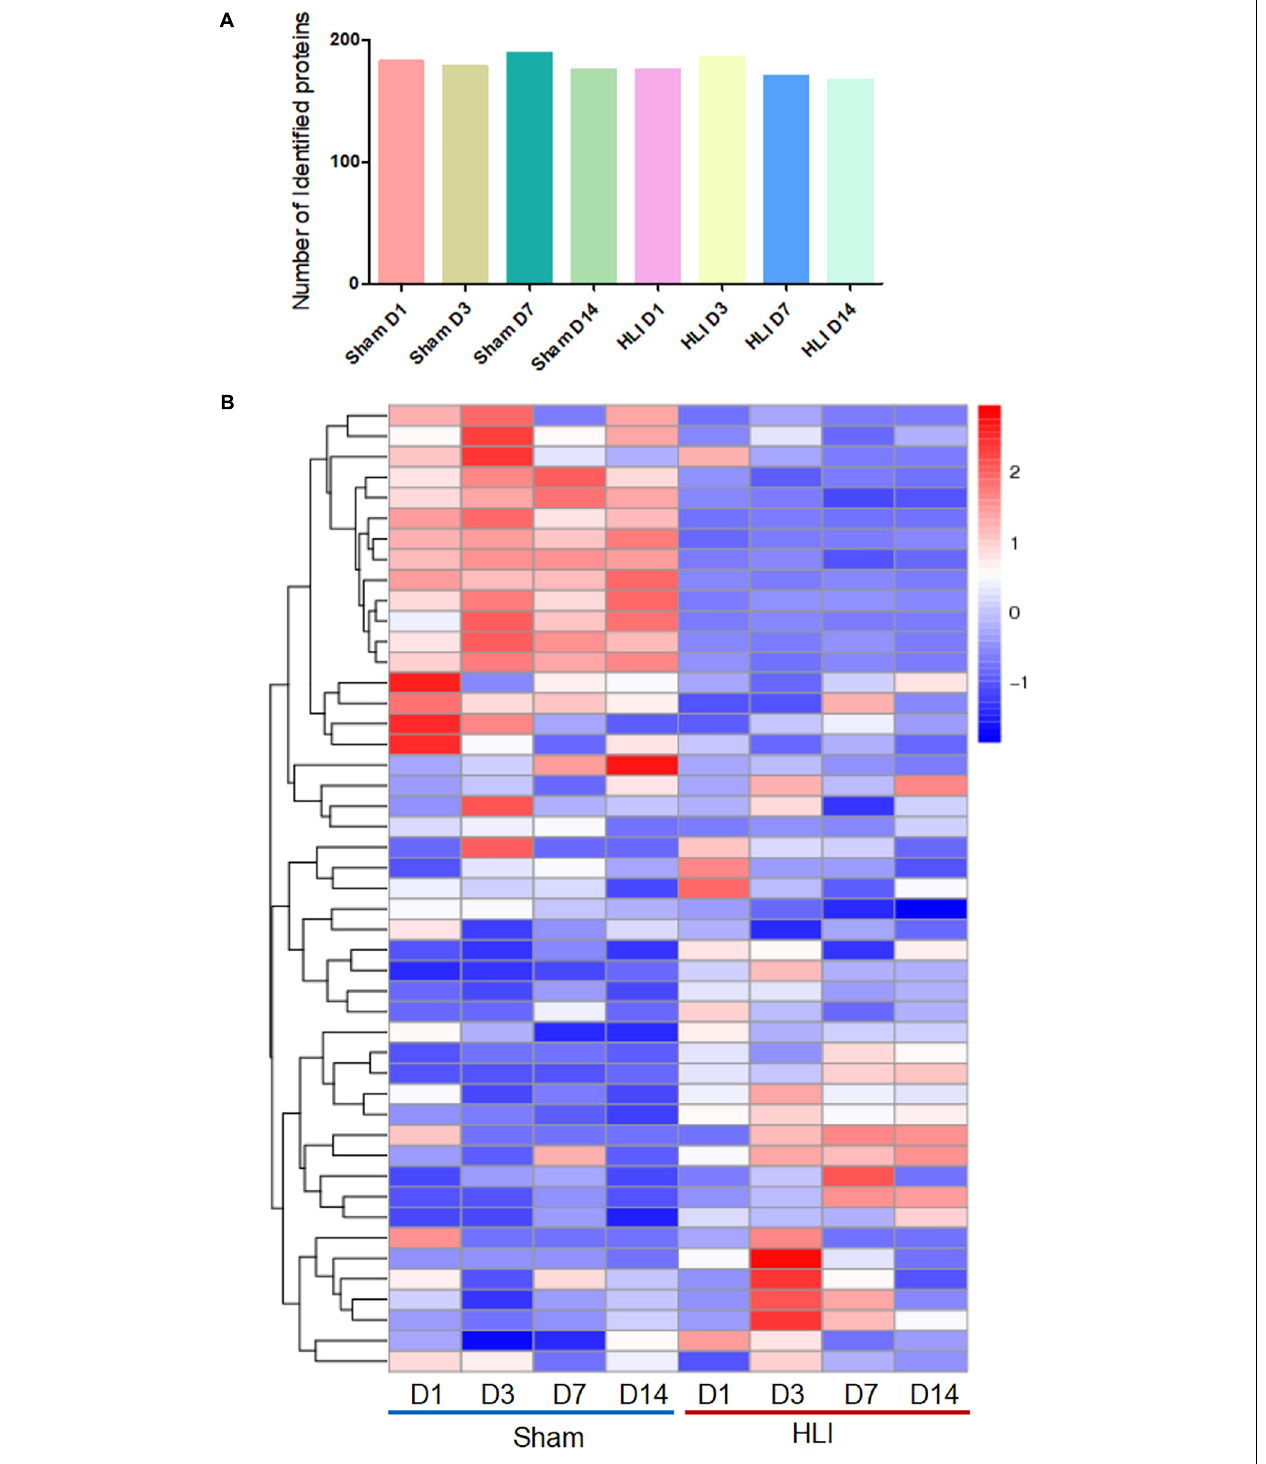
FIGURE 4 | Identification of MSC-specific proteome in the hindlimb. The mice were subjected to HLI or Sham surgery, and mutant cells were i.m. injected in the gastrocnemius muscle. Mice were then randomly grouped and received i.p. injections of ANL at days 0, 2, 6, and 13, gastrocnemius muscles were collect 24 h later for protein enrichment and biological analysis. n = 3 mice for each time point in each group. (A) Nearly 200 proteins were identified in the eight groups. (B) Hierarchical clustering of proteins expressed in all groups. Each column corresponds to the mean expression levels of proteins in 3 independent biological samples, and each row corresponds to a